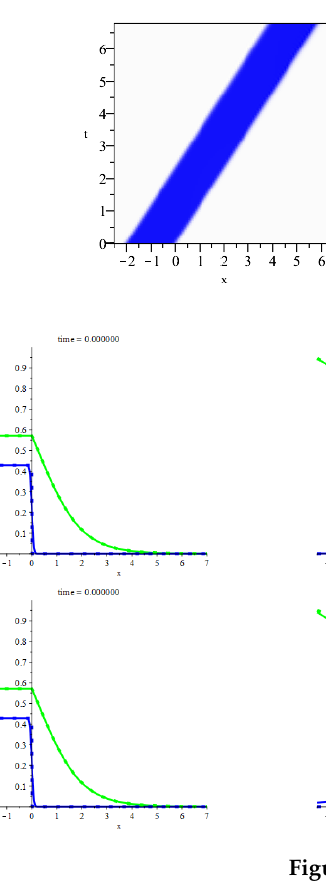
Figure 2. The figure illustrates propagating the solitary waves that are the slightly smoothed counter- parts of the shock patchy wave (45) when the resistivity, ν , and prey diffusivity, δ , take some small values. In Appendix A, there is the accurate exposition of all the parameter values and initial data that we have used for producing all the pictures displayed herein. The upper row of frames shows three distributions of the predators over x , t -plane which arise from propagating the shock and smoothed patchy waves. The left upper frame displays the former while the central and right frames display the latter for two different values of the resistivity. Both values are small, but the one corresponding to the central frame is substantially smaller. The saturation of blue is in use for indicating the predators’ density. The central and lower rows animate the propagation of the smoothed patchy waves shown in the middle and right frames in the upper row. For comparison, the shock patchy wave (that we have been showing in the left upper frame) is animated in the same frames synchronously. For capturing the former (latter), the solid (dotted) lines are in use, and the coloring of them distinguishes the species. Namely, for both waves, the profile of the predators’ (prey) density is blue (green) colored. The results presented above confirm the stability of the travelling patchy